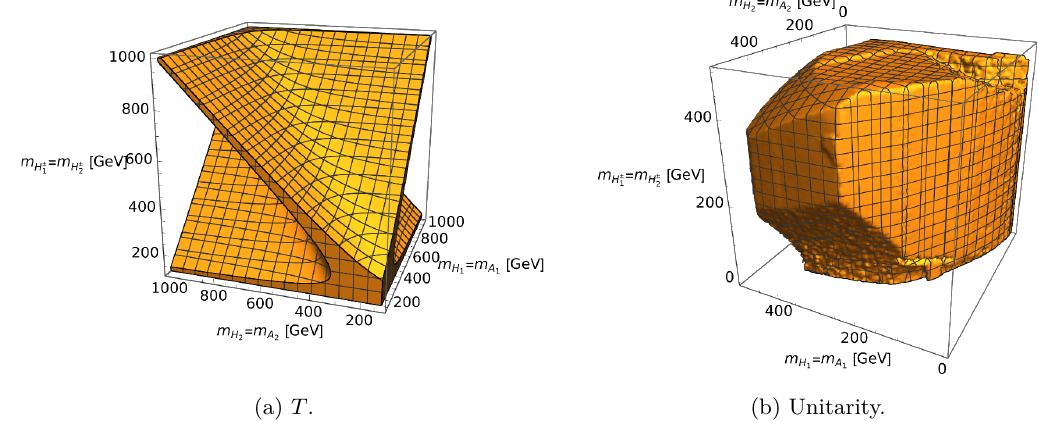
Figure 2. Regions allowed by the T -parameter at 99% level (a) and unitarity (b) for the ( v, 0 , 0) vacuum in the m H = m A vs. m H = m A vs. m = m space. The 4th free parameter, the H ± 1 H ± 2 1 1 2 2 mass of the SM-like Higgs m h , is set to 125.25 GeV. On the left panel we additionally assume that all masses are larger than m h while on the right one that they are larger than 1